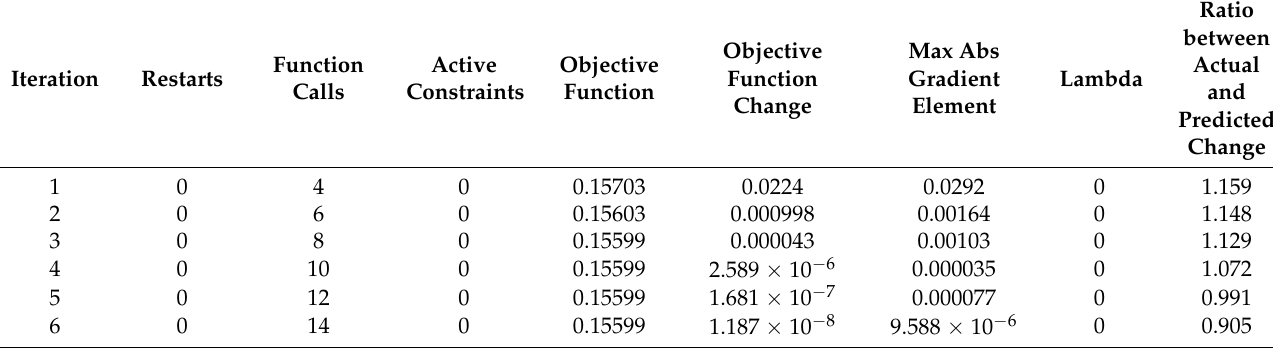
Table 7. Iterations of the first-order CFA model run on the post-trial data set.